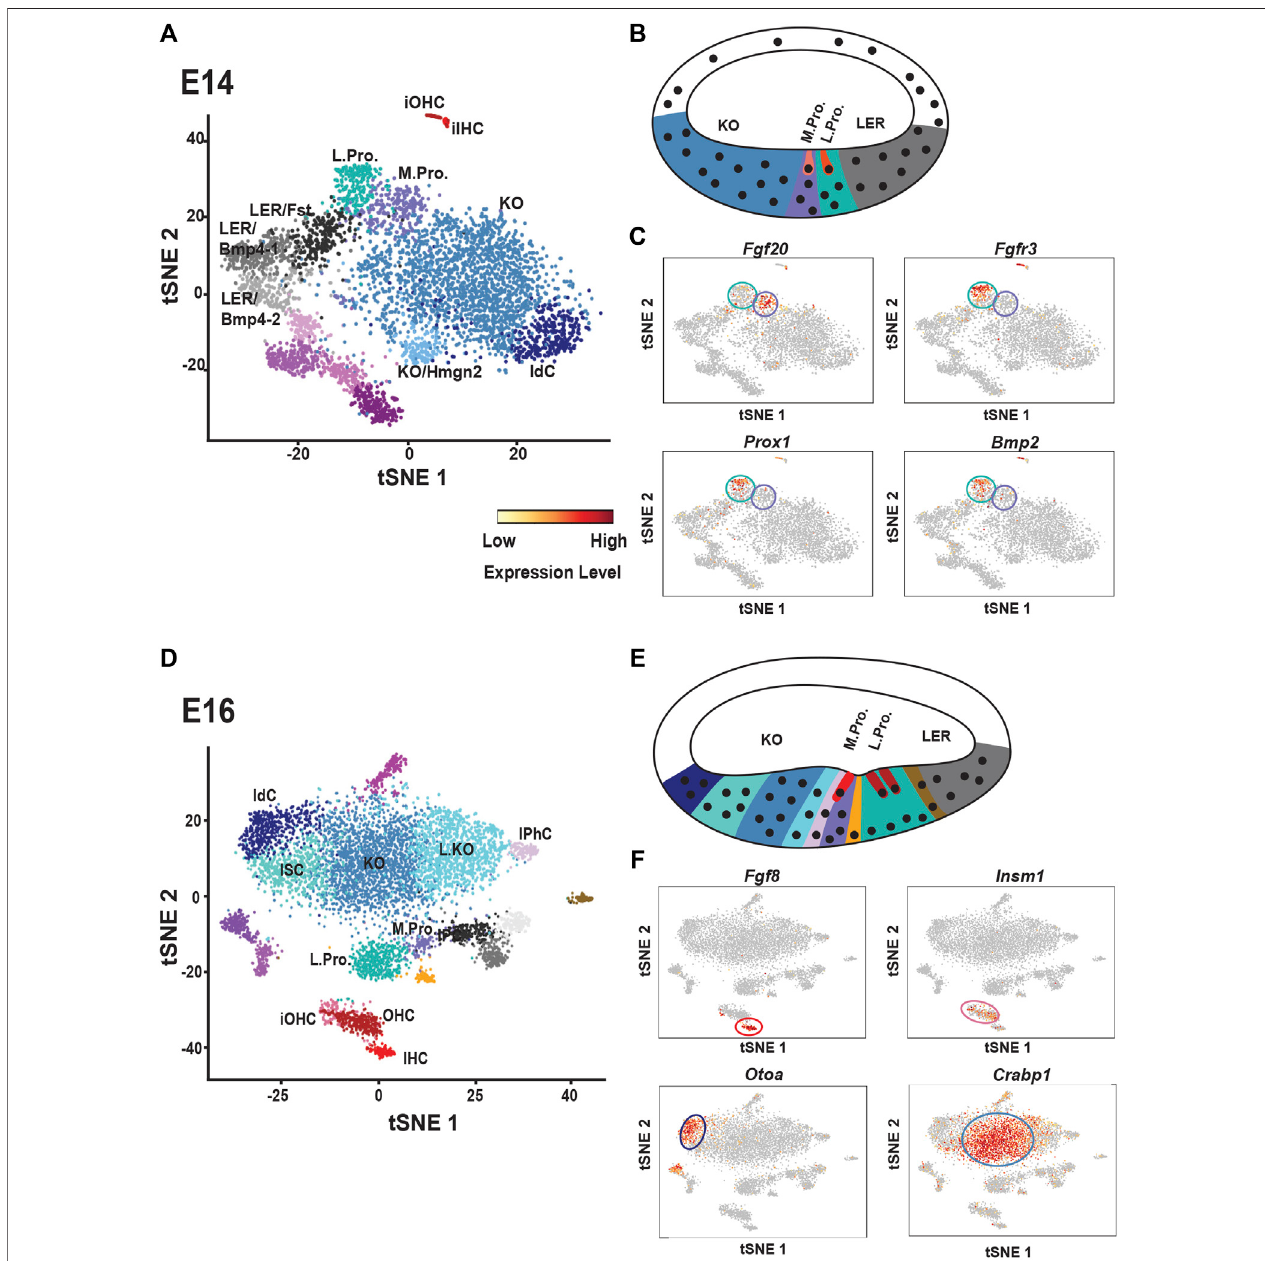
FIGURE 3 | Single cell analysis of cochlear development at E14 and E16. (A) t-distributed stochastic neighbor embedding (tSNE) plot of cochlear single cells collected at E14. Transcriptionally unique clusters are indicated in different colors. Clusters with transcriptional similarity, such as those determined to be located in Kolliker ’ s organ (KO) are colored similarly. Clusters discussed in the text are labeled. See text for details. (B) Schematic cross-section through the base of the cochlear duct at E14. The general locations of Kolliker ’ s organ (KO), the medial and lateral prosensory cells (M. Pro. and L. Pro.) and the lesser epithelial ridge cells (LER) whichwilldevelopastheoutersulcus,areindicatedandcolor-codedtomatchcellclustersin (A) .Note:KOandM.Pro.togetherconstitutetheGERwhileLERtechnically includes L.Pro. as well as the region labeled LER. (C) Feature plots showing expression of medial ( Fgf20 ) and lateral ( Fgfr3, Prox1, Bmp2 ) prosensory markers in the single cell data. Medial prosensory cells are circled in purple and lateral prosensory cells are circled in Aqua. Compare each feature plot with the plot in (A) Scale bar indicateslevelofmRNAexpressionpercell.Abbreviations:iOHC:immatureouterhaircells,OHC:outerhaircells,IHC:innerhaircells,IdC:interdentalcells. (D) tSNEplot of cochlear single cells collected at E16. As discussed in the text, note the increased diversity of cell types within KO and the transcriptional similarity between Inner Phalangeal Cells (IPhC) and KO cells. (E) Schematic cross-section through the cochlear duct at E16. Immature IHCs and OHCs (shades of red) can be identi fi ed as can developing inner pillar cells (gold) and some inner phalangeal cells (pink). However, medial prosensory cells (purple) are still present as well. Cells in KO have become transcriptionally heterogenous with different cell clusters located along the medial-to-lateral axis of the duct. See text for details. (F) Feature plots showing expression of makersfor developing IHCs ( Fgf8 ) and OHCs ( Insm1 ) aswell astwo genes, Otoa and Crabp1 that arerestricted tospeci fi cregions of KO cells. Abbreviations:IPC: inner pillar cells, ISC: inner sulcus cells All tSNE and feature plot images were generated using gEAR (umd.gear).